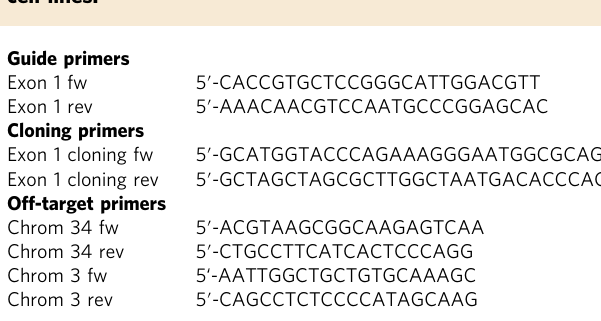
Table 2 Primers used for generation of the MDCK-PKD1 − / − cell